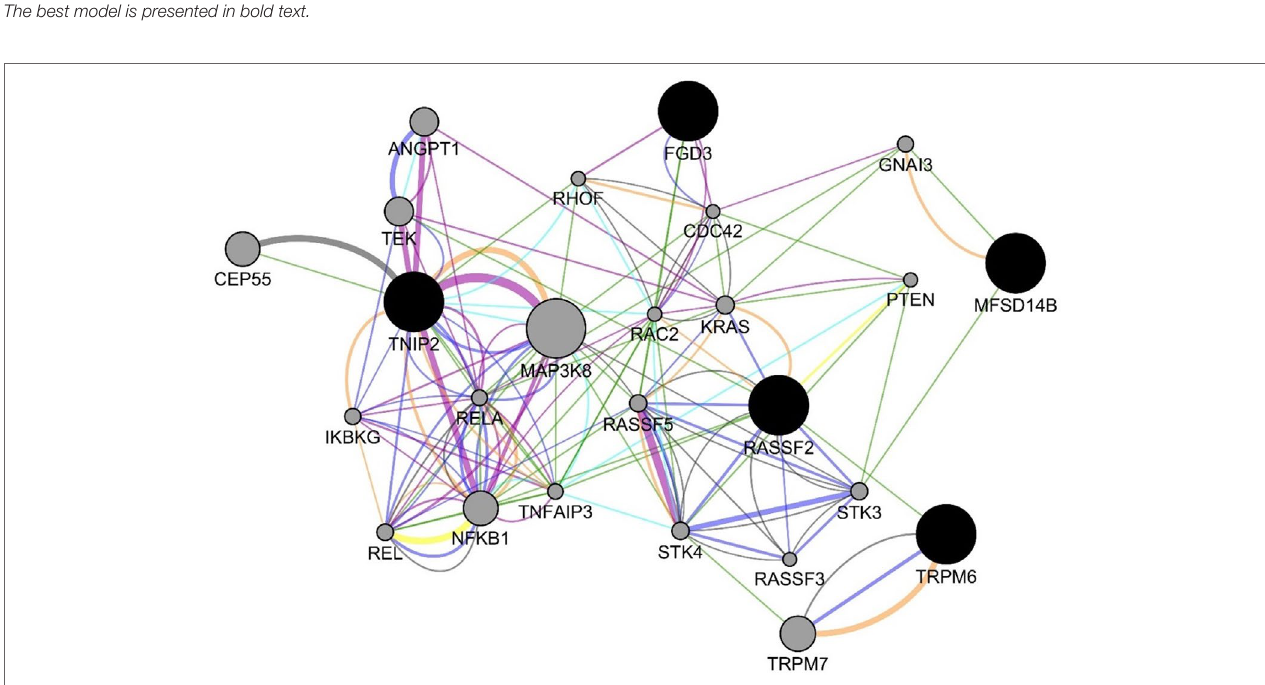
FIGURE 5 | Gene interaction network among the genes from the decision tree models using the methylomics data. The blue, green, orange, teal, purple, yellow, and gray edges represent various GeneMANIA networks: physical interaction network (weight 67.64), co-expression network (weight 13.50), predicted functional relationships between genes (weight 6.35), co-localization network (6.17), pathway network (weight 4.35), genetic interaction network (weight 1.40), and shared protein domain network (weight 0.59),